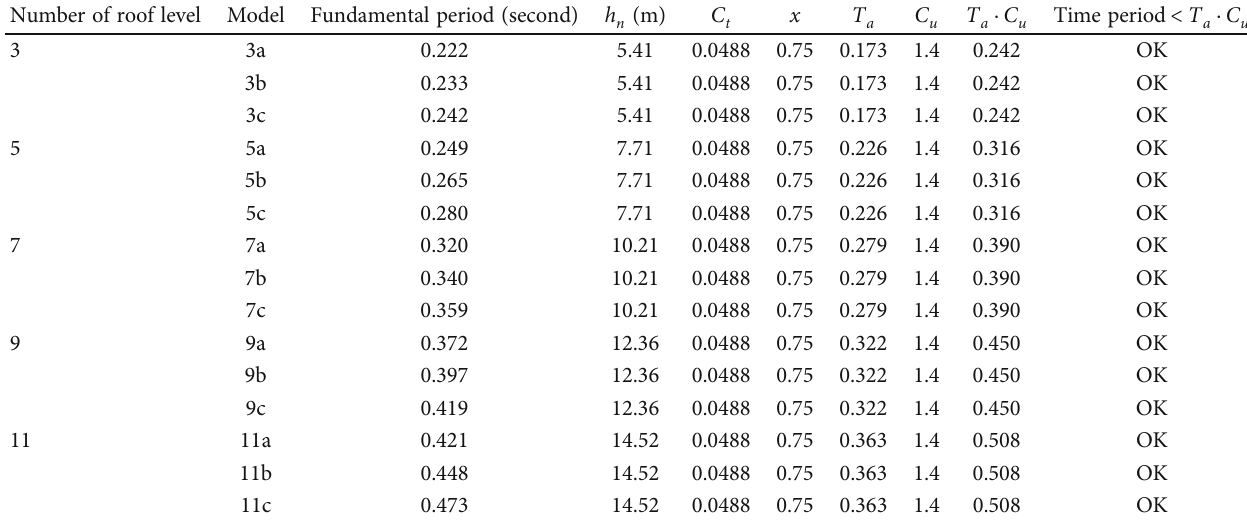
Table 1: The fundamental period of several roof levels 3, 5, 7, 9, and